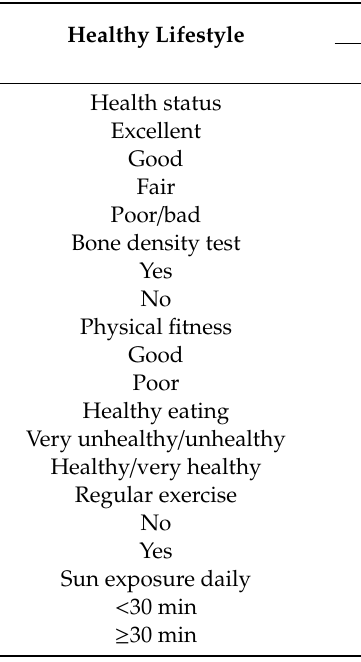
Table 4. Univariate relations of health literacy level and healthy lifestyle.